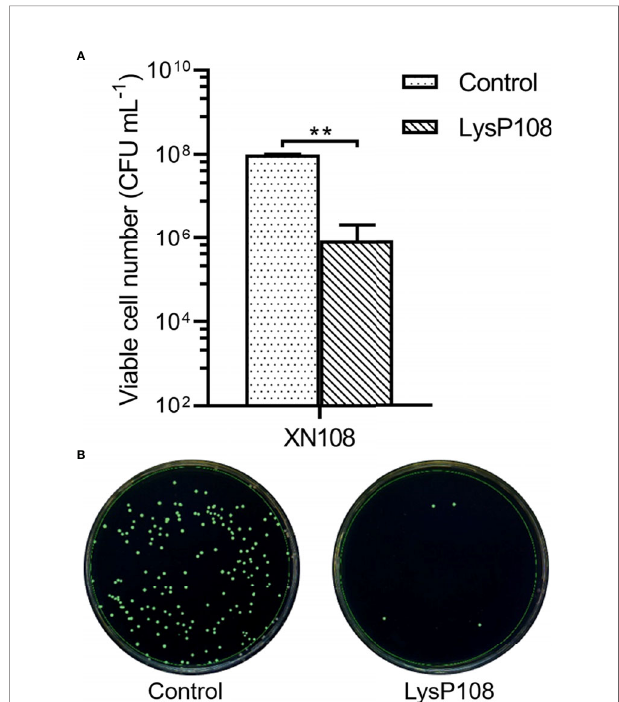
FIGURE 2 | Lytic activity of LysP108. (A) Identi fi cation of the lytic activity of endolysin LysP108 on XN108 by CFU reduction assay. (B) Scanning diagram of plate colony. (n=3). ** P <